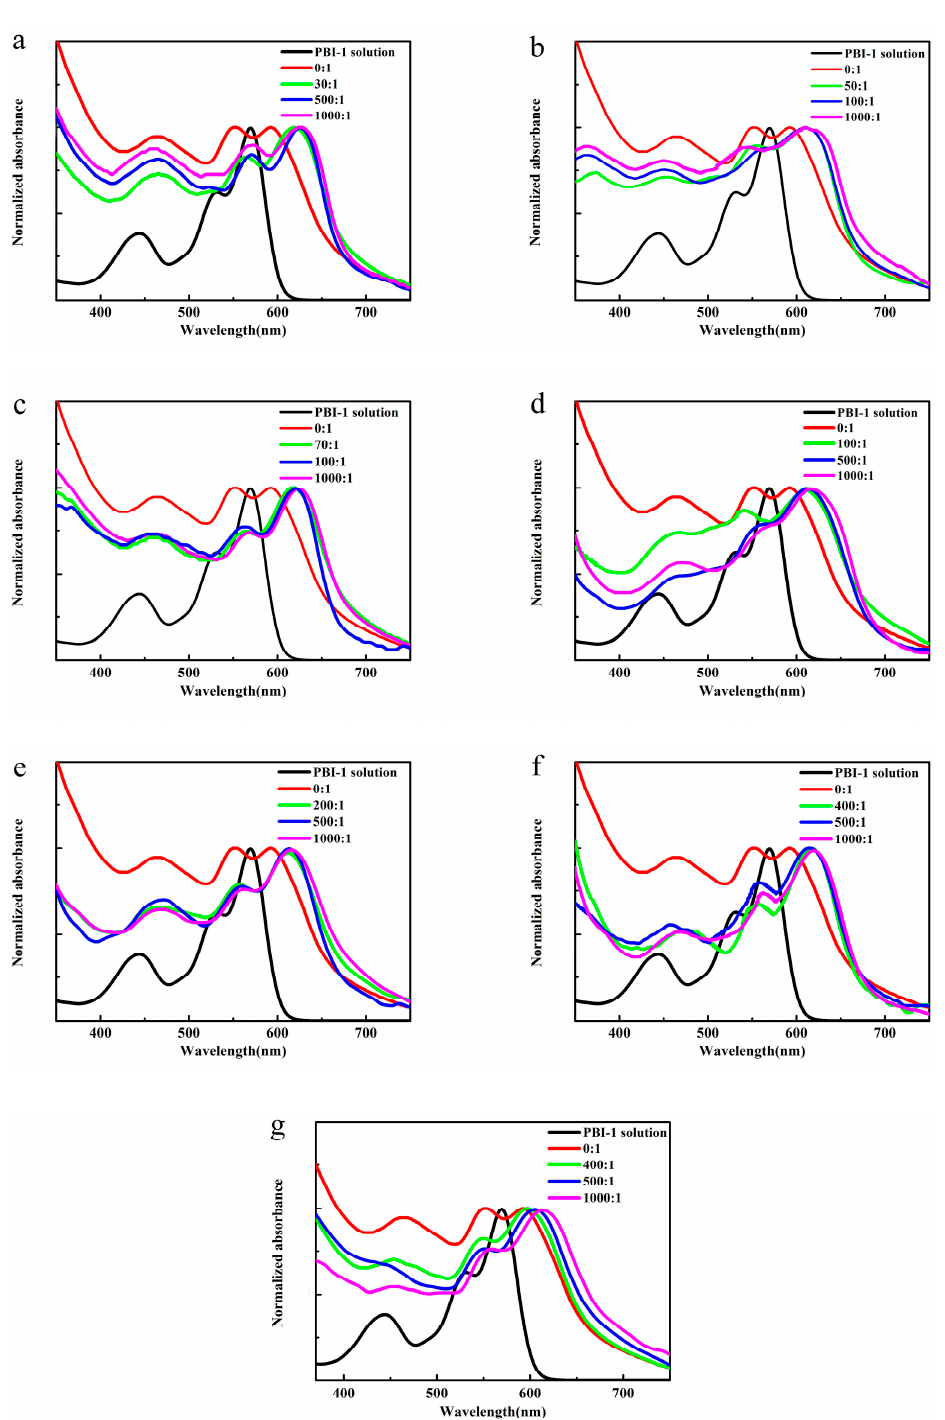
Figure 9. Normalized UV–vis absorption spectra of PBI-1 solution and PBI-1 aggregates at different r values assembled in various organic acids. ( a ) p-Toluenesulfonic acid, ( b ) oxalic acid, ( c ) malonic acid, ( d ) citric acid, ( e ) formic acid, ( f ) glutaric acid and ( g ) acetic acid.